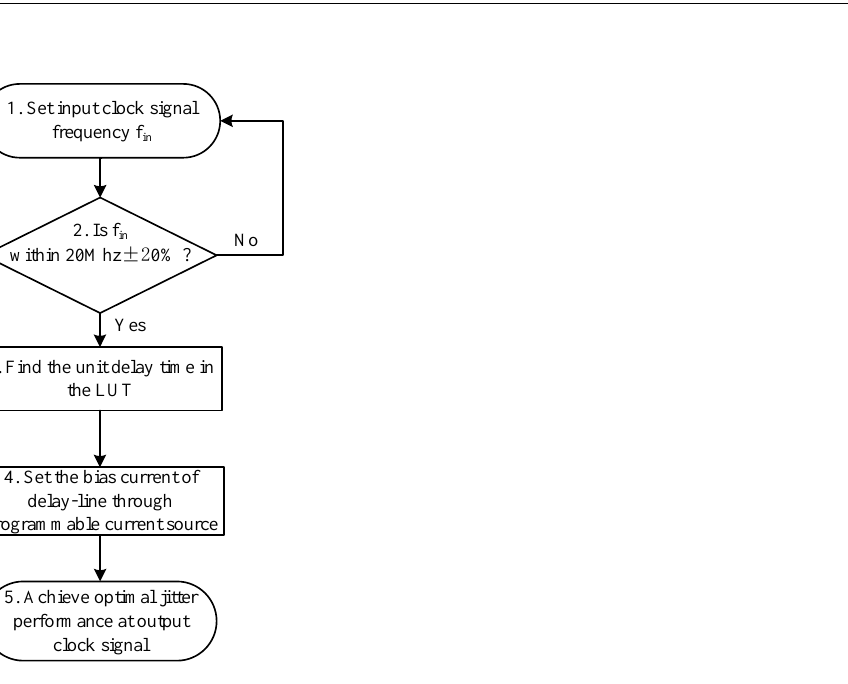
Figure 12. Working flow of frequency tracking mechanism in the proposed clock multiplier with various input clock frequencies.